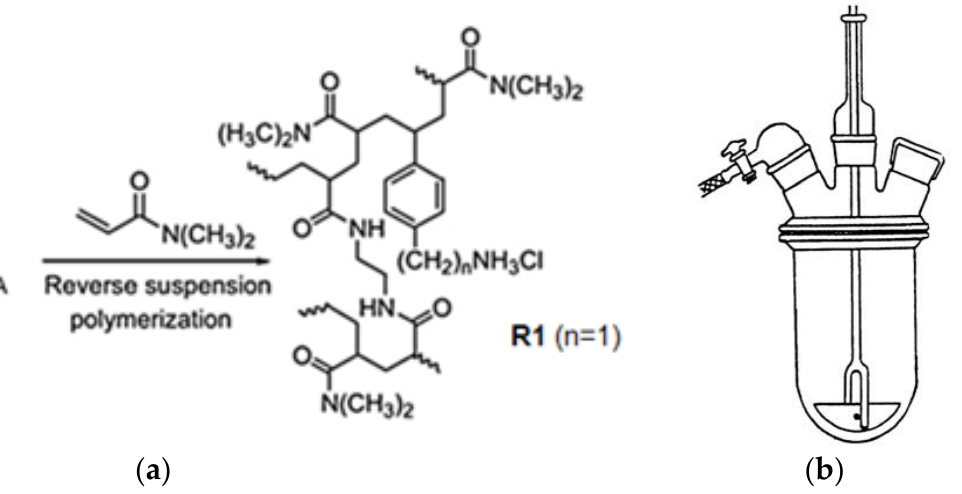
Scheme 1. Reverse suspension co-polymerization of M1 to achieve R1. The number 1 indicates the number of carbon atoms of the chain linking the styrene ring and the ammonium group in M1 as well as in R1 ( a ). Image of reverse suspension polymerization apparatus ( b